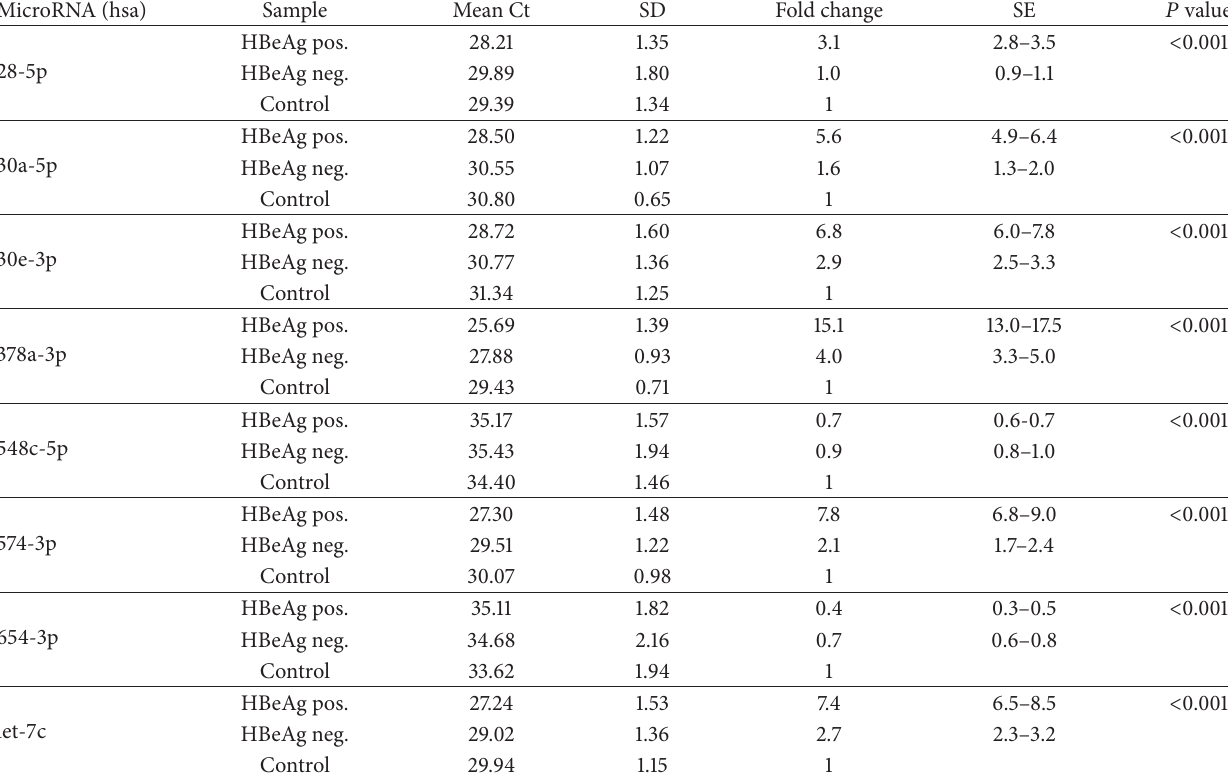
Table 3: MicroRNA plasma levels in children with CHB relative to healthy